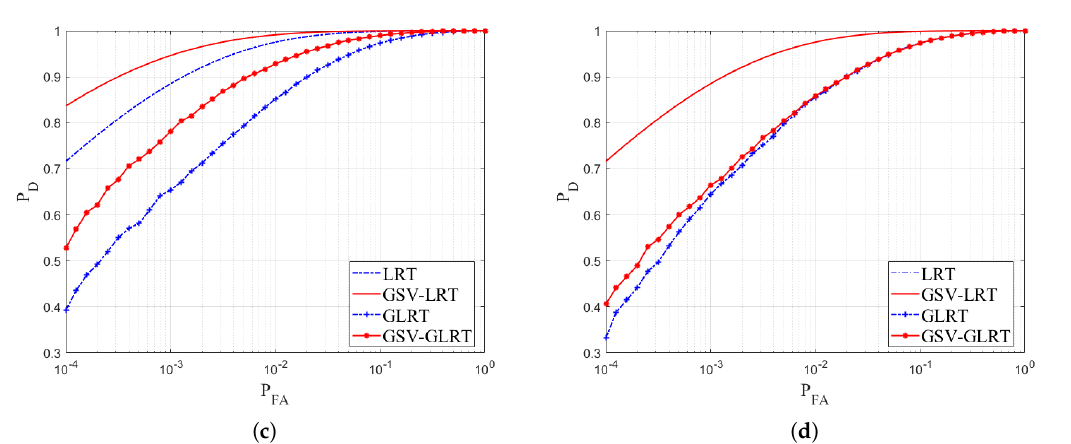
Figure 3. Receiver Operating Characteristic (ROC) curves, V r = 3 m/s, signal-to-clutter ratio (SCR) = –5 dB, clutter-to-noise ratio (CNR) = 10 dB, P FA = 10 − 4 , three channels, b1 = 0 m, b2 = 0.15 m, b3 = 0.3 m, ( a ) β = [ 0.8,0.8,1,0.4,0.4 ] T ⊗ 1 3 , high defocus and high neighborhood correlation ( b ) β = [ 0.6,0.6,1,0.2,0.2 ] T ⊗ 1 3 , moderate defocus and moderate neighborhood correlation ( c ) β = [ 0.3,0.3,1,0.1, 0.1 ] T ⊗ 1 3 , slight defocus and slight neighborhood correlation ( d ) β = [ 0,0,1,0, 0 ] T ⊗ 1 3 , full focus and neighborhood irrelevant.